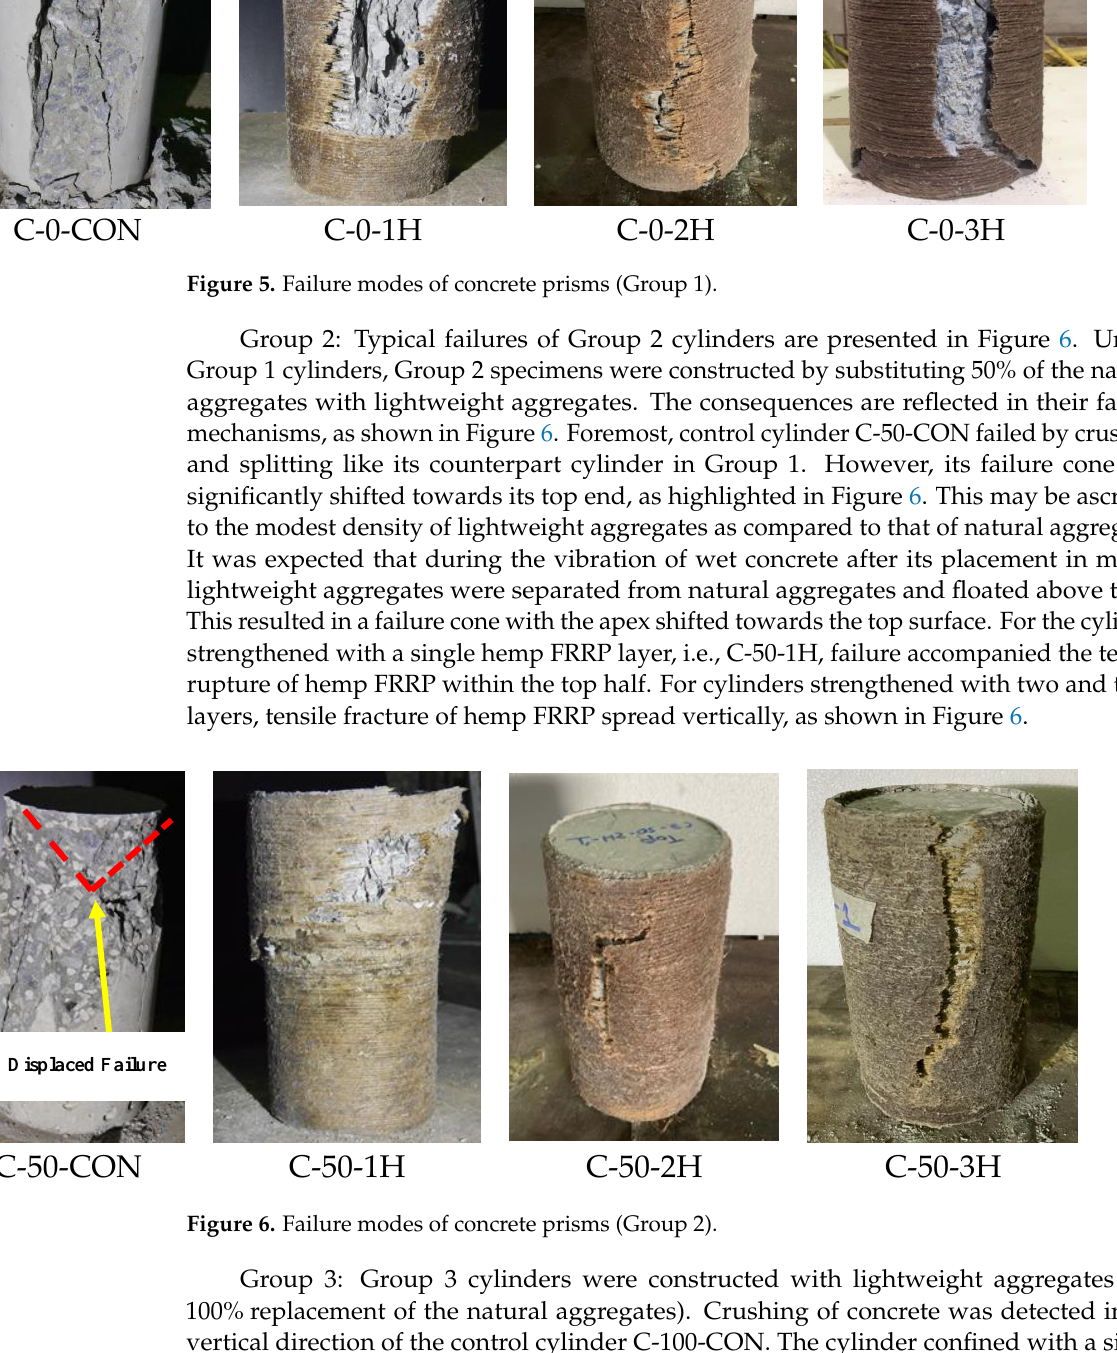
C-100-3H Figure 7. Failure modes of concrete prisms (Group 3). 3.2. Ultimate Load and Strain One of the key features of external wraps is to enhance concrete inherited compres- sive strength and the corresponding strain. Cylinders strengthened with hemp FRRP ex- hibited both these enhancements. Table 3 summarizes the peak stress and the ultimate strain of the cylinders. As stated in earlier sections, two cylinders were cast for each